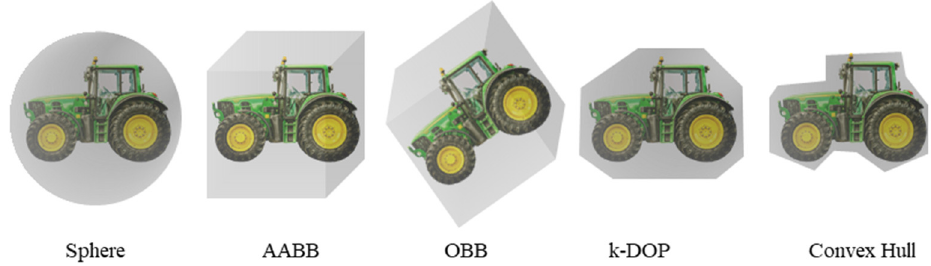
Figure 2. Examples of bounding volumes for a tractor [10].